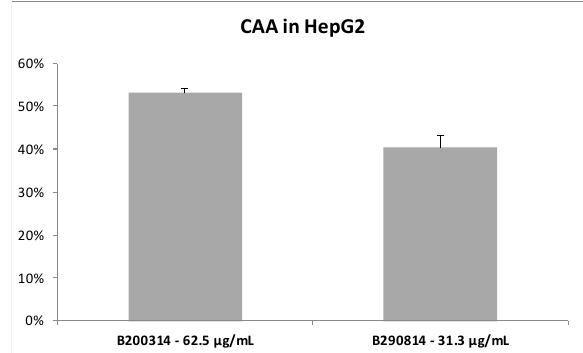
Figure 1 . Cellular antioxidant activity (CAA) in HepG2 cells as a % of the control. The control consisted of cells with the DCFH-DA probe and the AAPH peroxyl radical initiator, but in the absence of samples; the blank consisted of cells exposed to only the DCFH-DA probe. The values shown are the mean ± SD of three independent experiments.